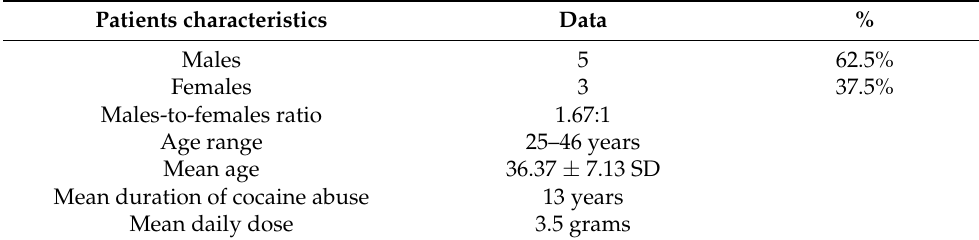
Table 1. Patients’ clinical data.